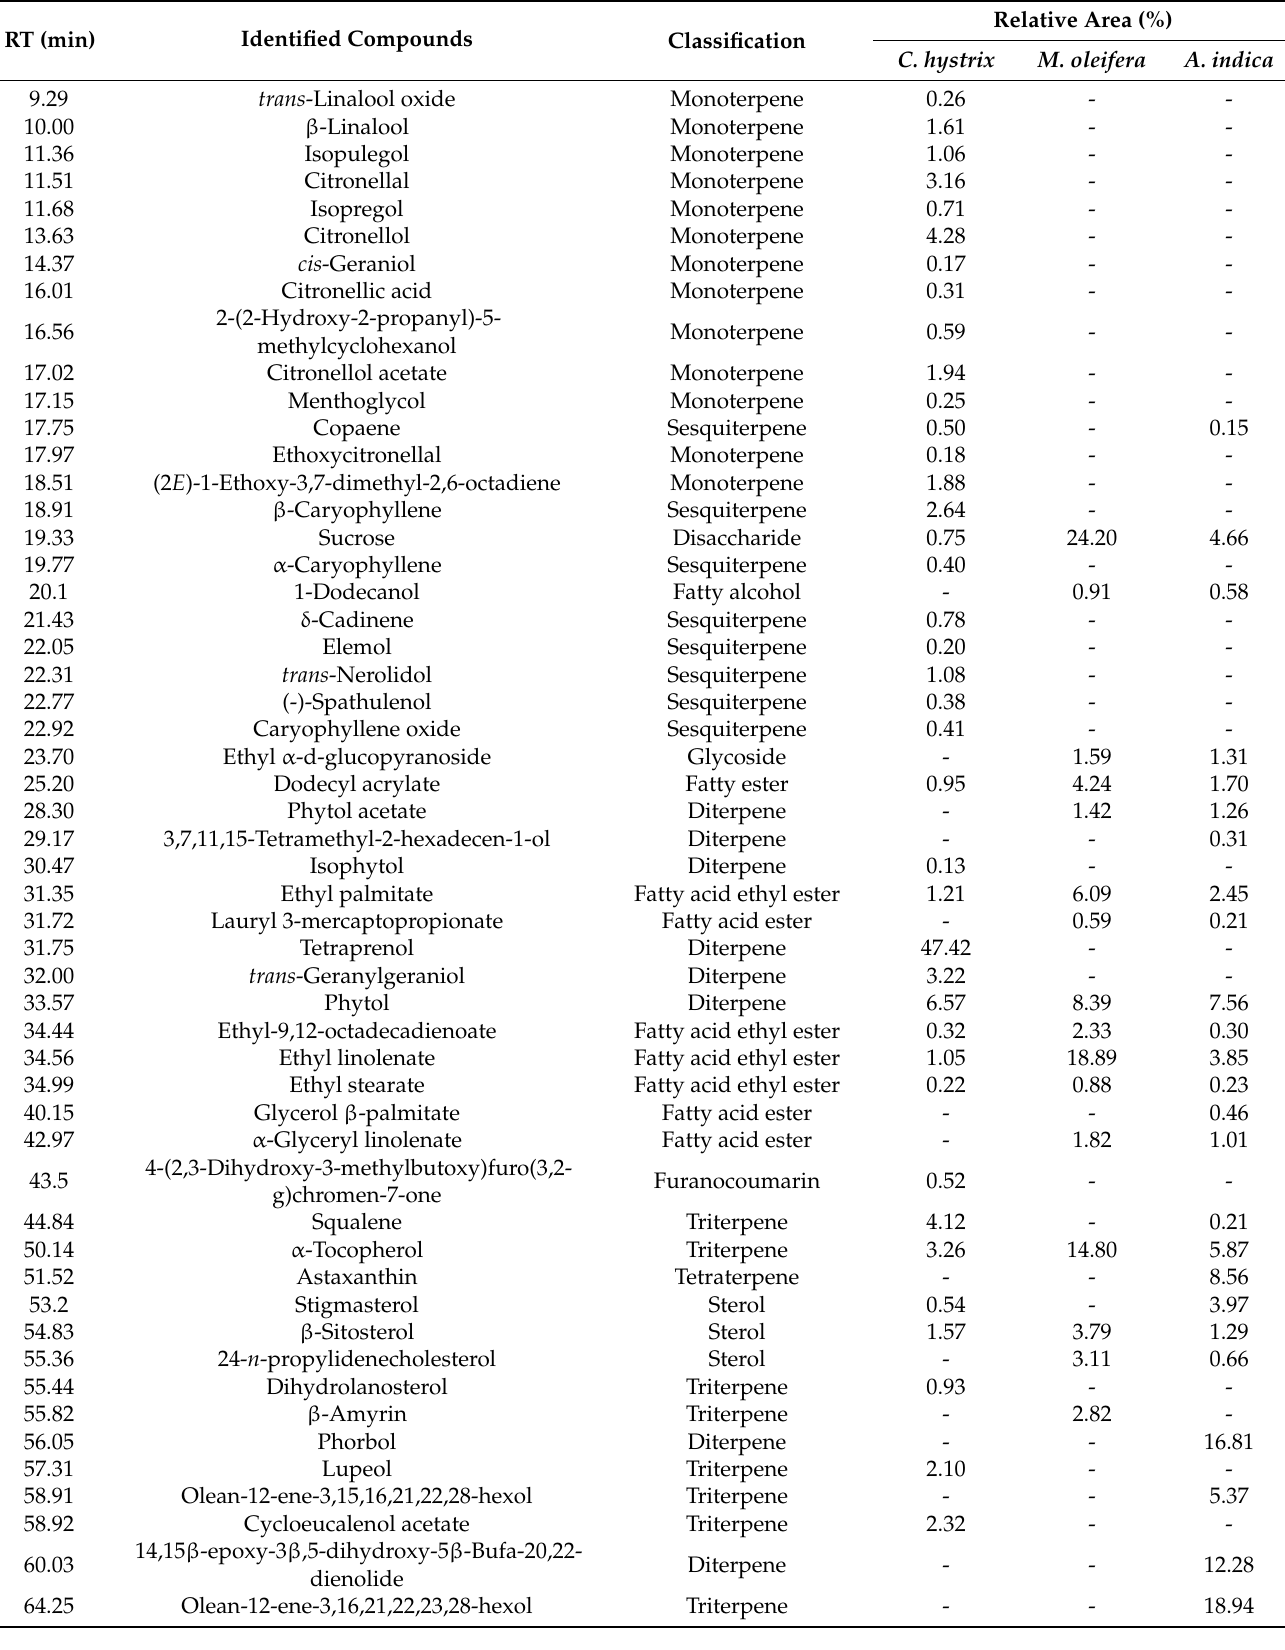
Table 1. Chemical constituents identified by GC-MS from C. hystrix , M. oleifera and A. indica ethanolic